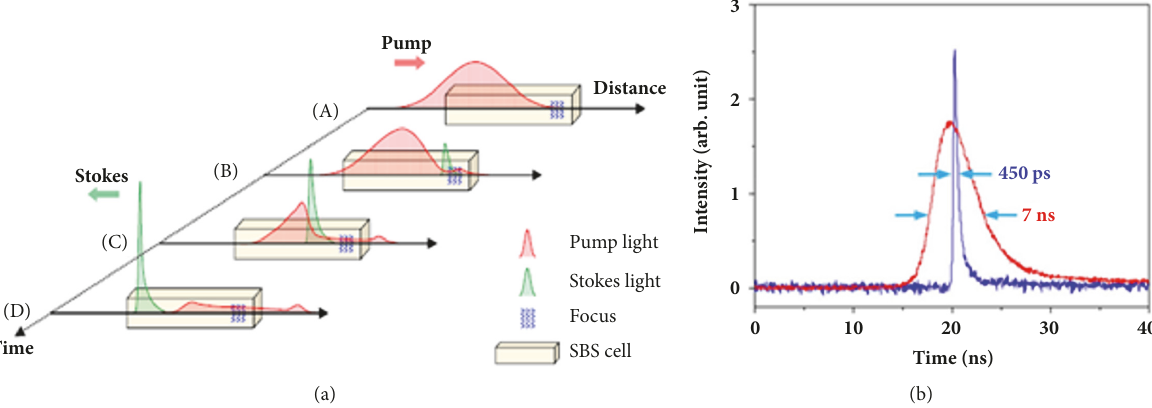
Figure 8: (a) Schematic of short pulse formation; (b) some experimental results by the University of New Mexico group [adapted from [11]].